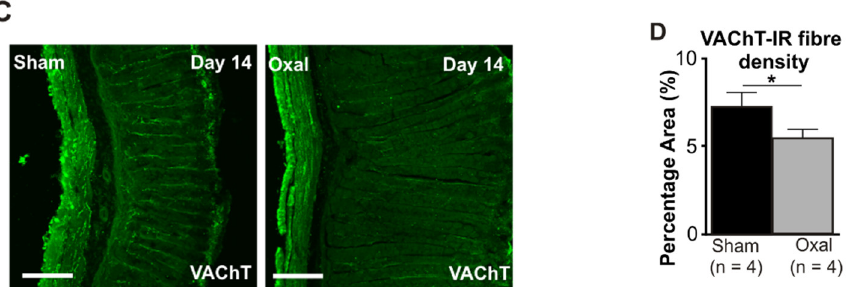
Figure 4. Effects of repeated oxaliplatin administration on cholinergic fibres in the stomach. ( A ) Cholinergic fibres labelled with the vesicular acetylcholine transporter (VAChT) in wholemount preparations of myenteric ganglia at days 3, 7, and 14 following the injection of sterile water (sham) and oxaliplatin (oxal). Scale bar: 100 µm. ( B ) Group data showing the density of VAChT-IR fibres per 0.25 mm 2 area in wholemount preparations of the gastric corpus of sham- and oxal-treated mice. ( C ) Cholinergic fibres labelled with VAChT in cross-section preparations of the gastric corpus at day 14 following the injection of sterile water (sham) and oxaliplatin (oxal). Scale bar: 100 µm. ( D ) Group data showing the density of VAChT-IR fibres in cross-section preparations of the stomach of sham- and oxal-treated mice. Data are presented as the mean ± SEM. The number of animals is shown in parentheses. *** p < 0.001; * p < 0.05.